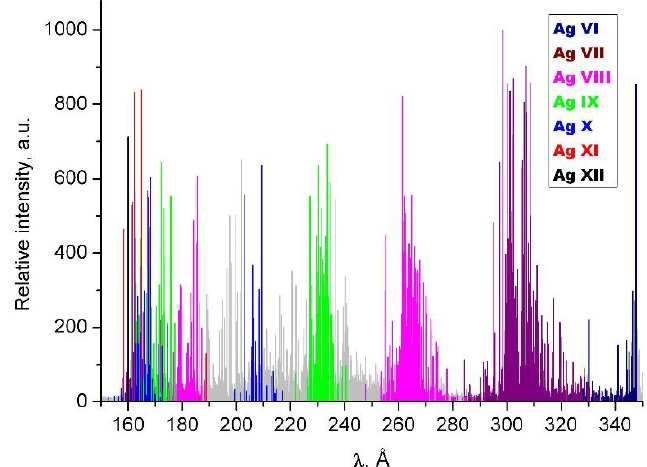
Figure 1. Spectrum of silver in the region 150–350 Å excited in a vacuum spark. Lines of different ion spectra are marked by different colours: Ag VI—royal blue, Ag VII—wine, Ag VIII—magenta, Ag IX—green, Ag X—blue, Ag XI—red, Ag XII—black and unidentified lines—gray.